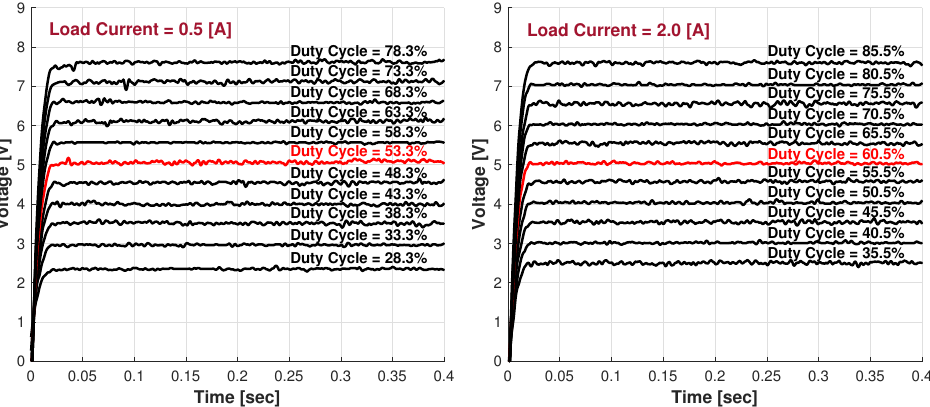
Figure 29. Experimental performance evaluation of the optimized converter against multiple duty- cycle step signals, highlighting where the nominal operation is